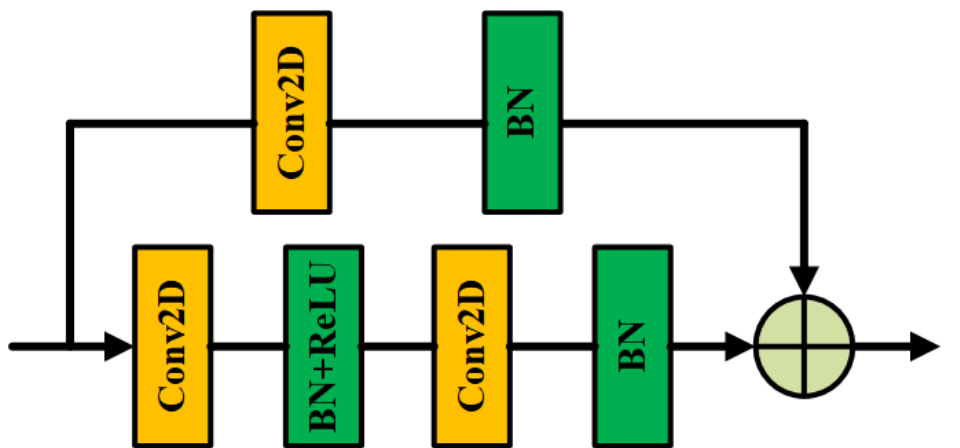
Figure 5. Architecture of the residual convolution (ResConv)